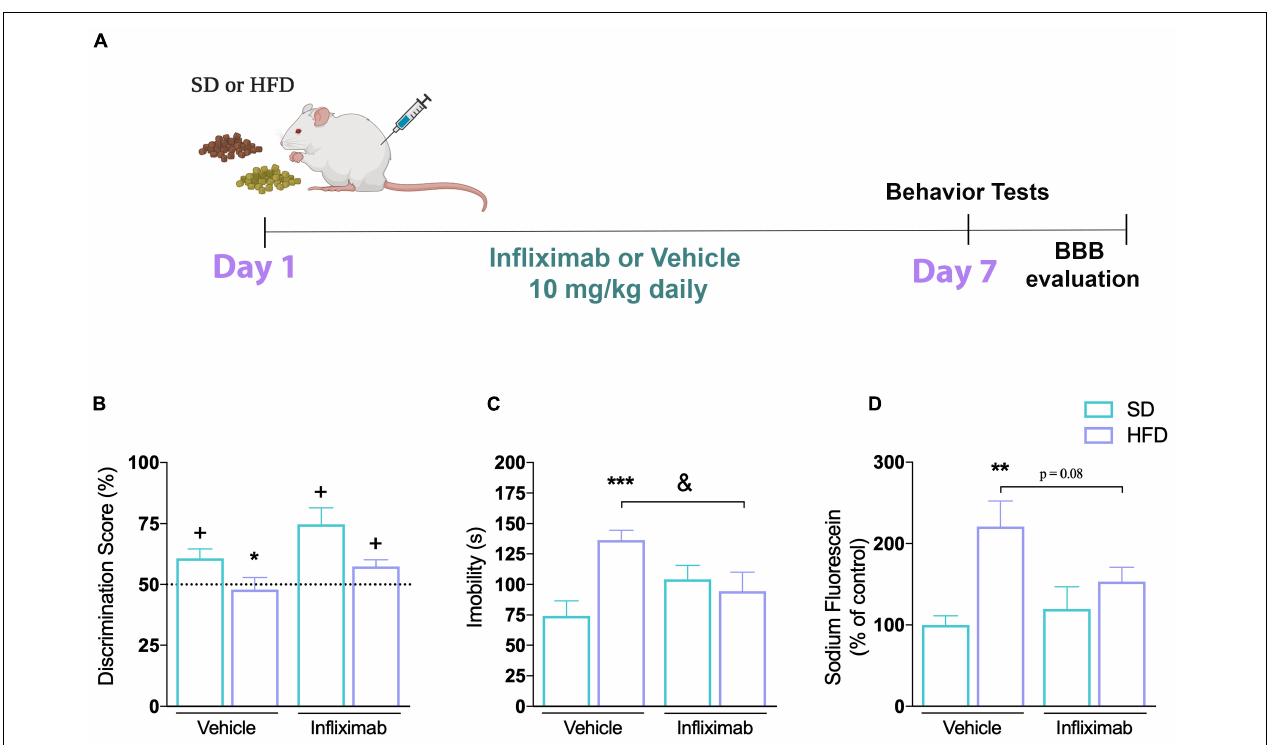
FIGURE 5 | Anti-inflammatory effect on CNS alterations induced by high-fat diet. (A) Experimental design of mice fed either SD or HFD for 7 days and treated with saline or infliximab (10 mg/kg). (B) Cognitive performance of treated mice ( n = 7–8/group; one-sample t -tests). (C) Time of immobility in TST ( n = 7–8; two-way ANOVA followed by Duncan post hoc test). (D) Hippocampal sodium fluorescein assay ( n = 4/group; two-way ANOVA followed by Duncan post hoc test). Values are mean ± SEM. + p < 0.05 vs. chance levels (50% of a new object investigation in test trial). ** p < 0.01 compared with mice fed with SD and & p < 0.05 compared HFD mice treated with vehicle. * p < 0.05, ** p < 0.01, *** p < 0.001 SD vs.